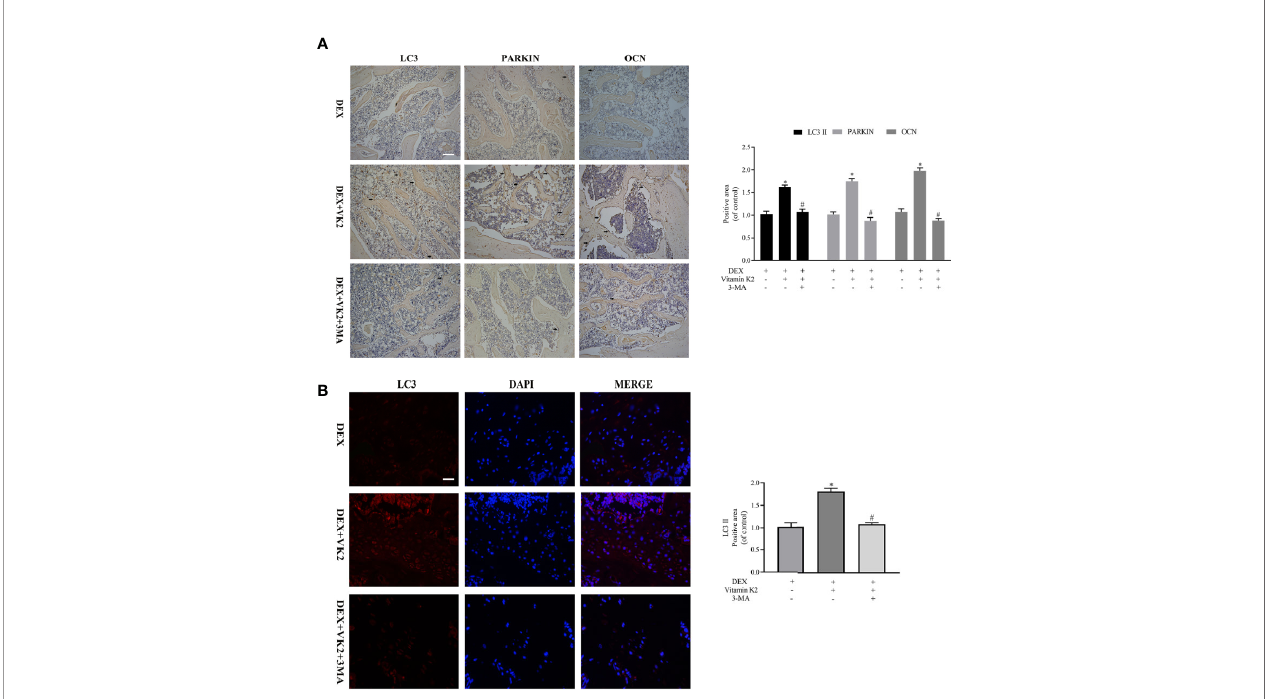
FIGURE 6 | VK2 restored mitophagy and revived function of osteoblasts in vivo . The expression of the proteins in the femurs of the rats were further detected by (A) Immunohistochemical staining and quantitative analysis (black arrows: positive area); (B) Immuno fl uorescence and quantitative analysis. Data was expressed as